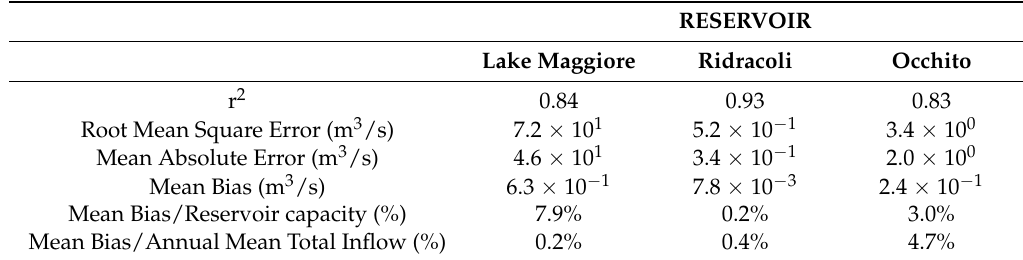
Figure 6. Regression coefficients from the SPI-Q model calibration. ( a ) Lake Maggiore. ( b ) Ridracoli. ( c ) Occhito. Table 2. Statistics of the residues (observed-simulated monthly inflow) of simulations from the CALIBRATION